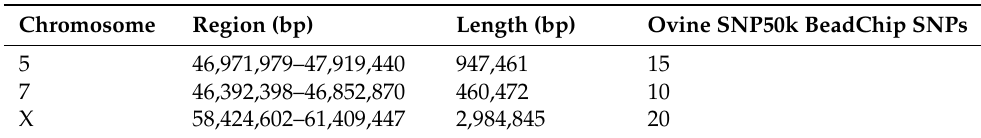
Table 1. Regions chosen for fine mapping in this study and the number of SNPs that were previously genotyped in these regions using the Ovine SNP50k